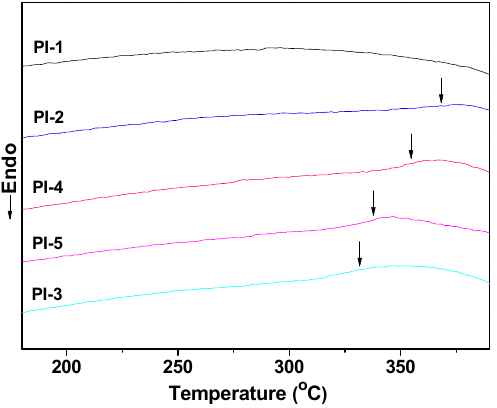
Figure 3. Differential Scanning Calorimetry (DSC) curves of polyimides.